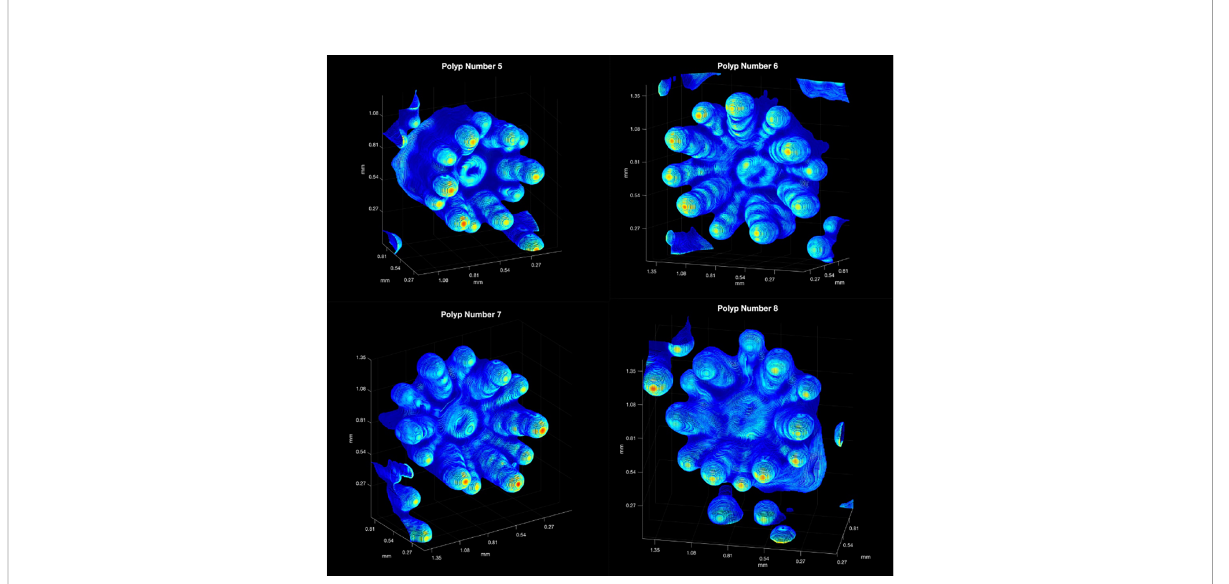
FIGURE 7 The computed 3D colored point clouds for the square matrices surrounding Polyps 5,6,7 and 8 (see Figure 2). The backscatter range was rescaled linearly from 1 = red (highest value), to 0 = dark blue (lowest value), using the original backscatter values from the interpolated, unprocessed, OCT data. Red implies strong backscatter and dark blue weaker backscatter. Note that point clouds from adjoining polyp are show in the periphery of the fi